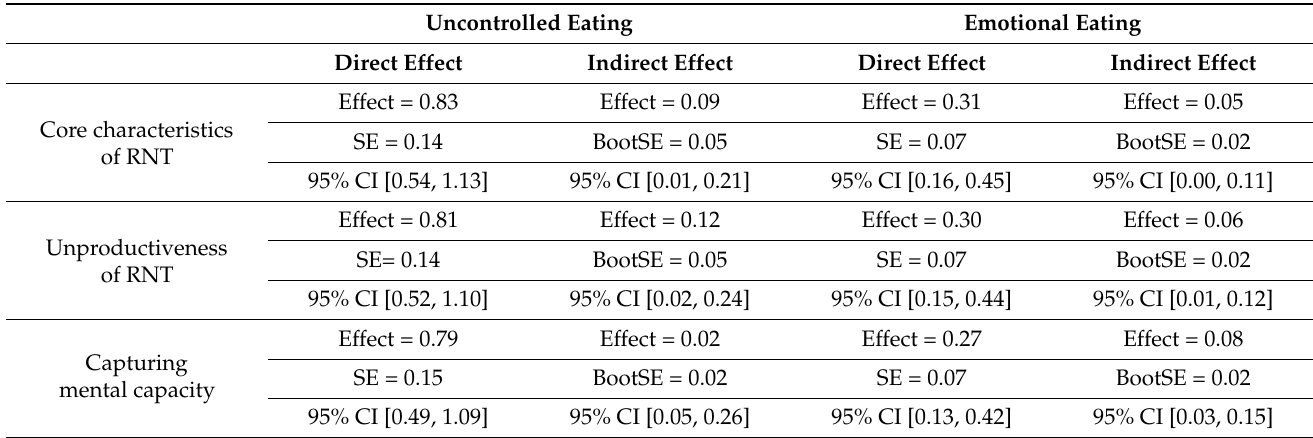
Table 2. Mediation analysis for relationship between dieting, rumination and disinhibited eating patterns in women with normal body